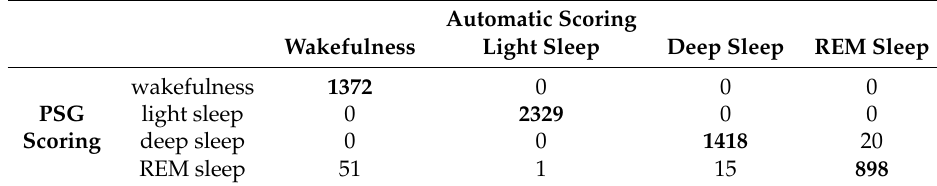
Table 5. Confusion matrix for patients with SDB.